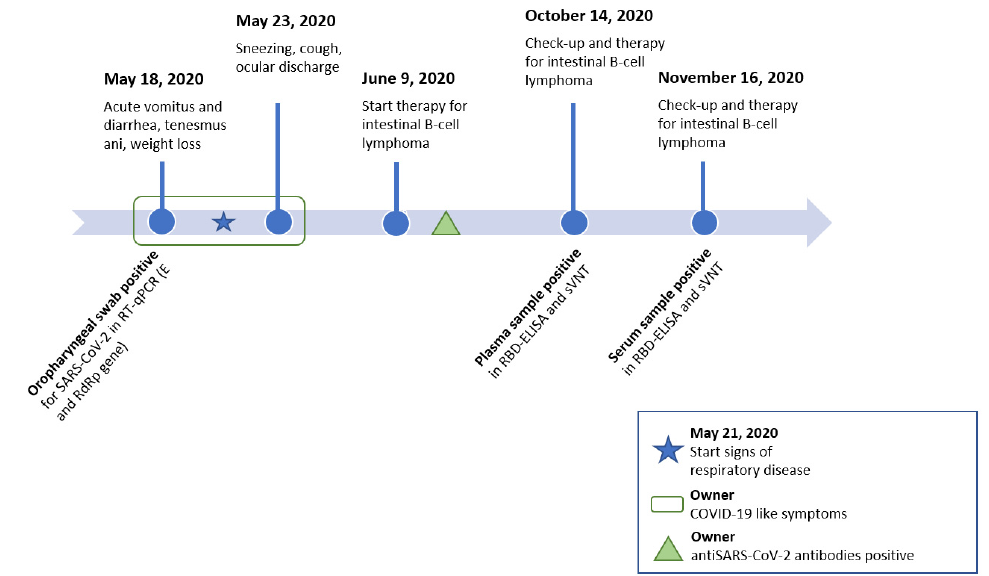
Figure 1. Timeline of consultations at the veterinary clinic ( top ) and sample collection for SARS-CoV-2 diagnostics including the results ( bottom ). Signs of respiratory disease (as indicated with the blue star) started three days after swab samples were collected. Abbreviations: real time reverse transcriptase polymerase chain reaction (RT-qPCR), envelope gene ( E gene), RNA-dependent RNA polymerase gene ( RdRp gene), receptor binding domain enzyme-linked immunosorbent assay (RBD-ELISA), surrogate virus neutralization test (sVNT).